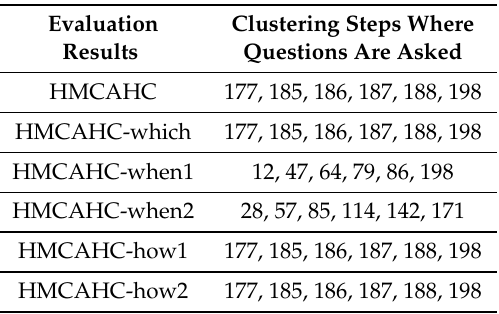
Table 4. Questions asked in the LFW Data